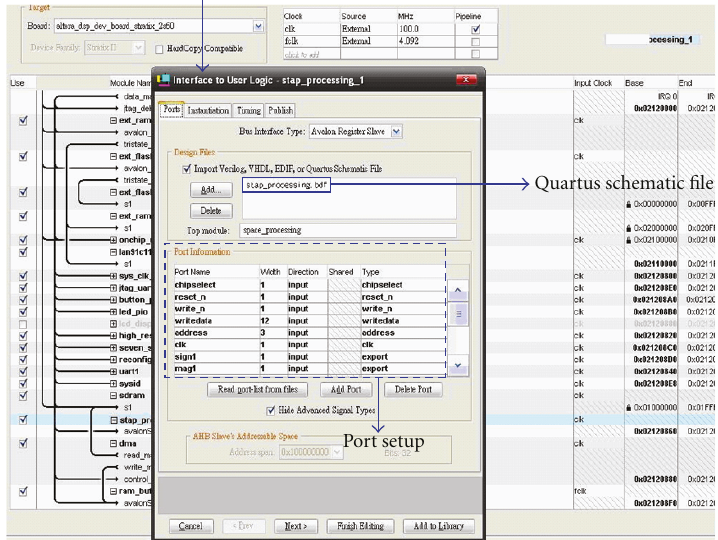
Figure 6: SoPC builder